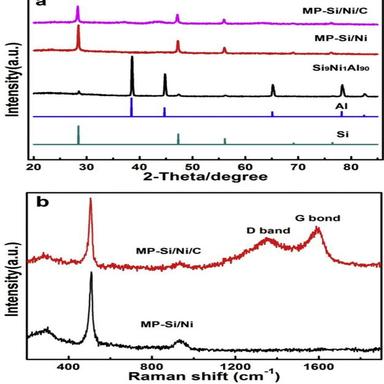
(a) XRD data of the Si9Ni1Al90 alloy, the sample after alloying, and the final MP-Si/Ni/C with the standard patterns of Al and Si included for comparison. (b) Raman spectra of MP-Si/Ni and MP-Si/Ni/C composites.